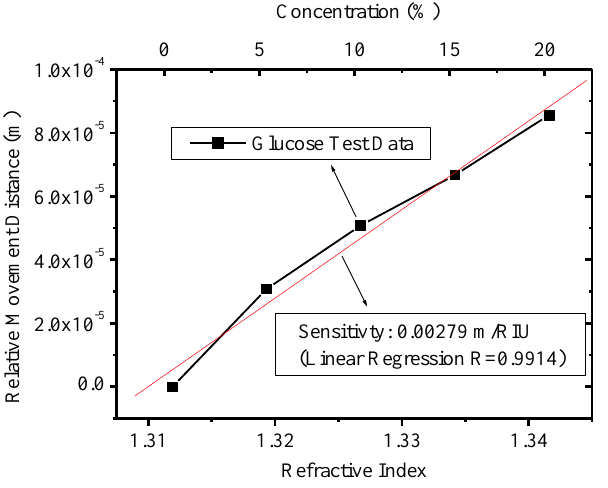
Figure 11. The sensitivity from the refractive index and relative movement distance in TE polarization.